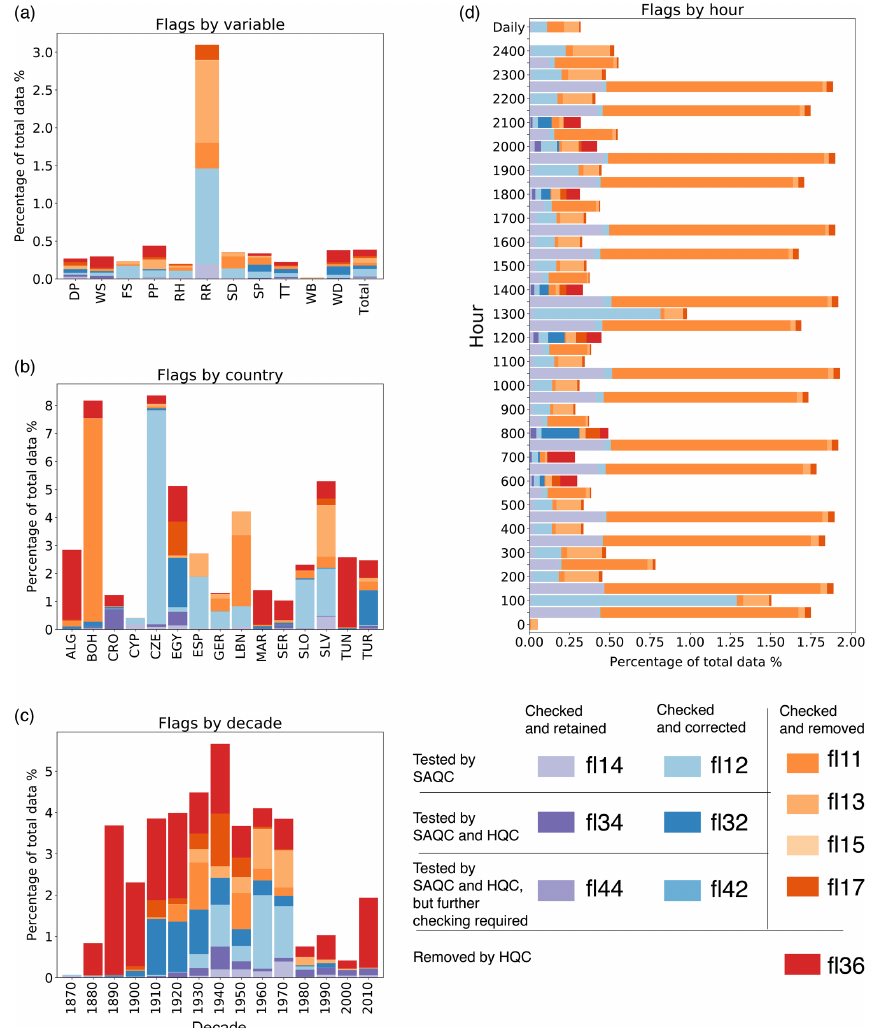
Figure 10. Total counts (in percentage) of error flags by countries (a) , variables (b) , observation times (c) and decades (d) derived from SAQC application to the dataset. Purple indicates values that were flagged but verified; blue indicates values that were flagged and corrected; and red and orange indicate values that were flagged and removed as errors. Variable acronyms are as those described in Table 1. Flag descriptions are given in Table